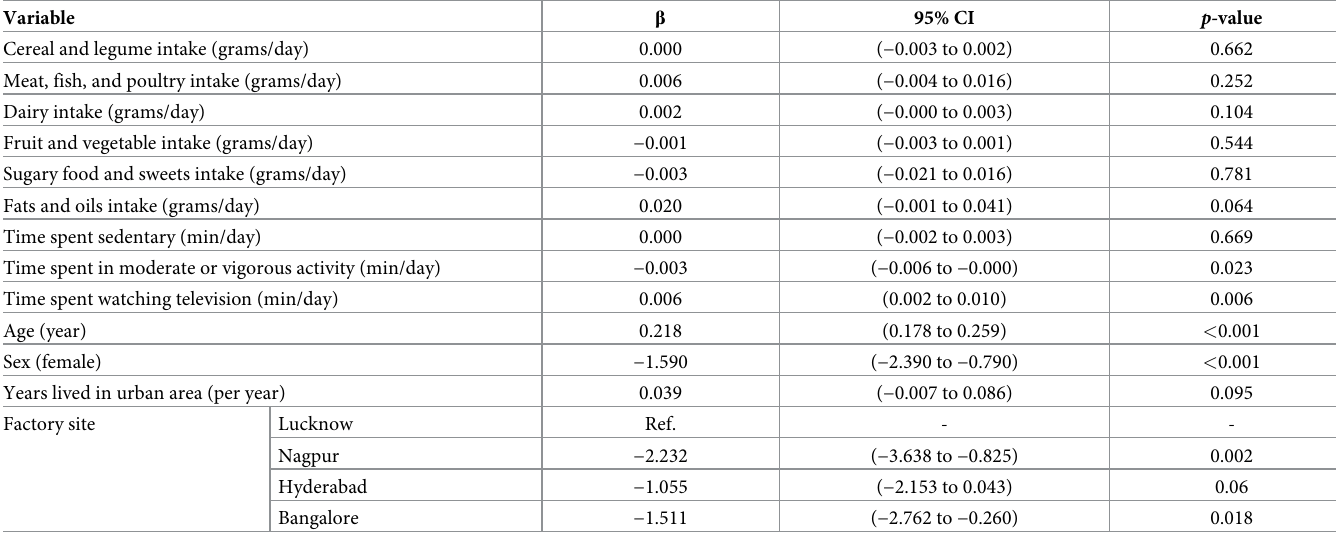
Table 3. Multivariable model for association of difference in a selected diet and physical activity behaviours on the difference in % body fat between urban and rural siblings in the Indian Migration Study, 2005–2007. Variable β 95% CI Cereal and legume intake